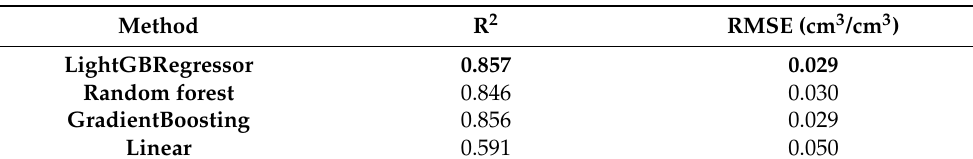
Table 4. Summary of the contribution scores for the five most important predictors. Table 3. Summary of model performance in predicting SSM at 9-km grid cells, with bold numbers denoting the best values.